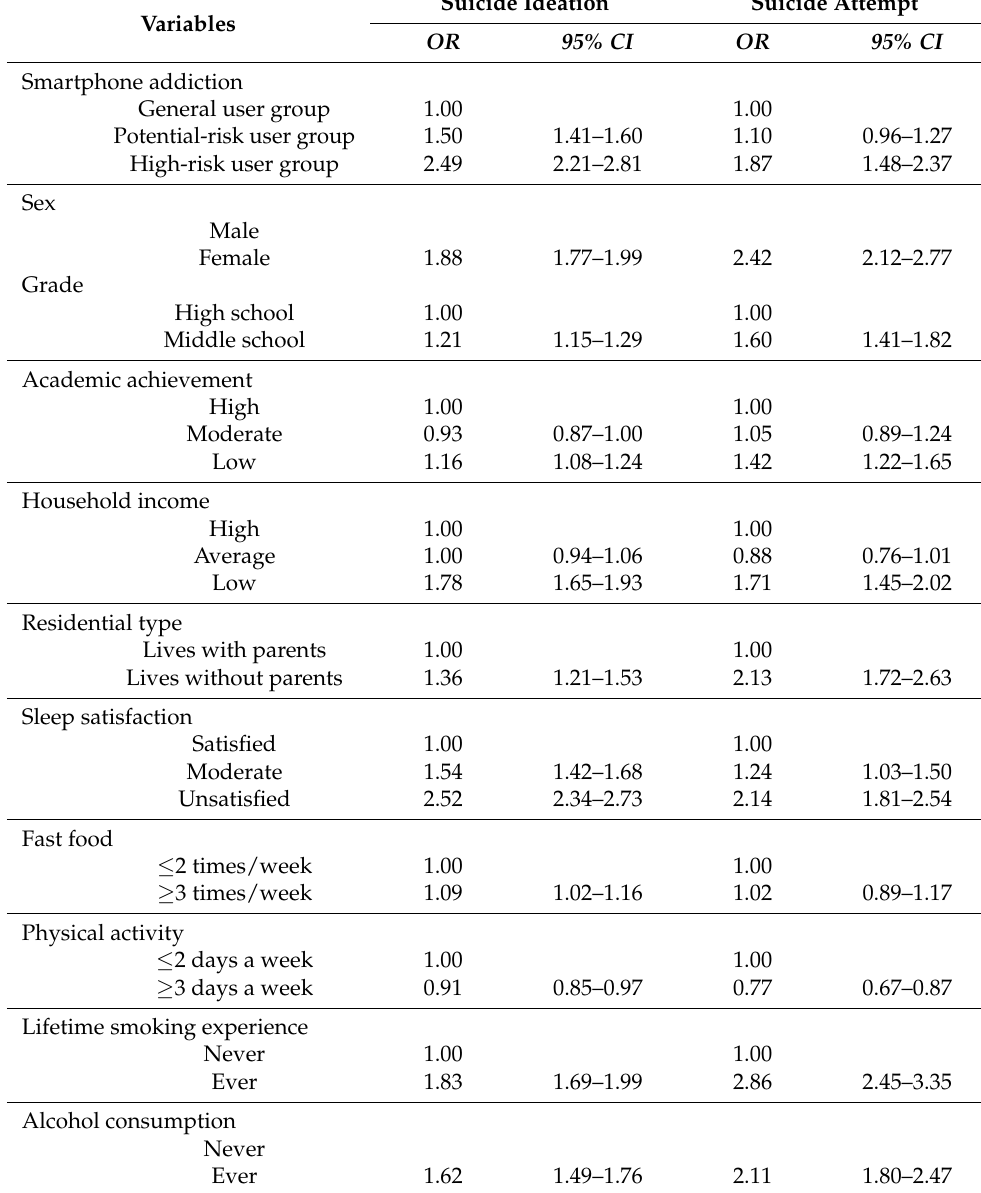
Table 3. Results of multivariate logistic regression analysis for the factors associated between Smart- phone addiction risk and suicidal ideation and suicide attempt. Suicide Ideation Suicide Variables